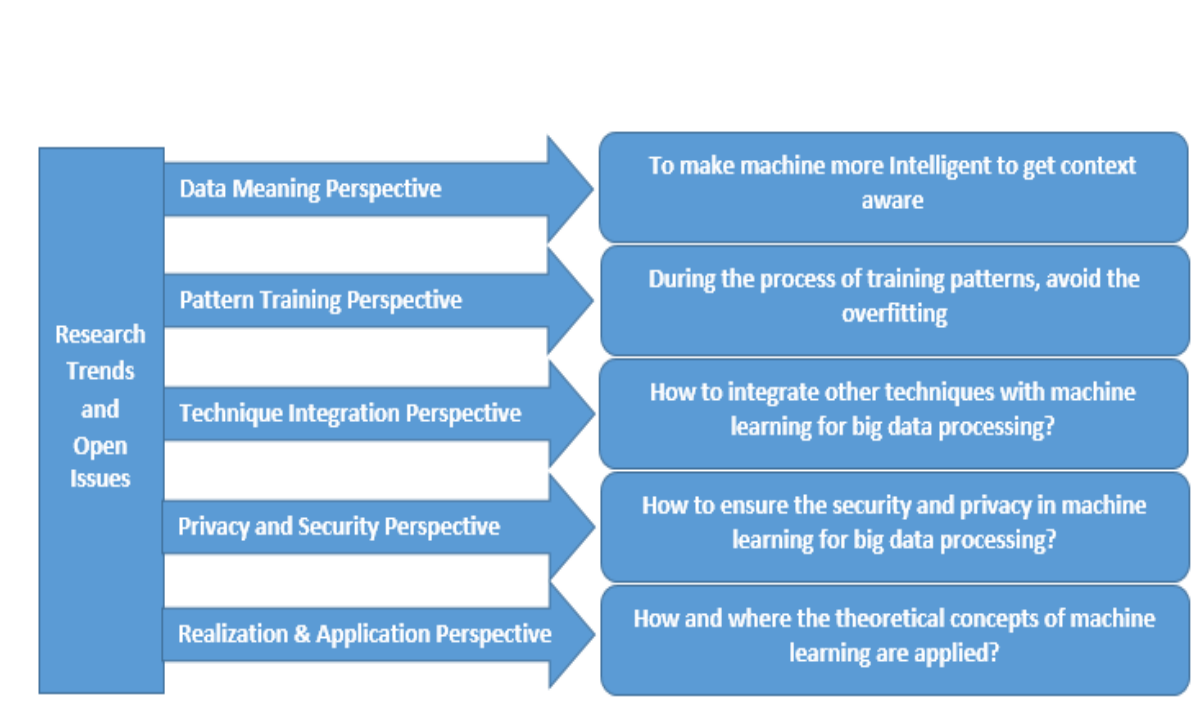
Figure 5. Research Trends and Open